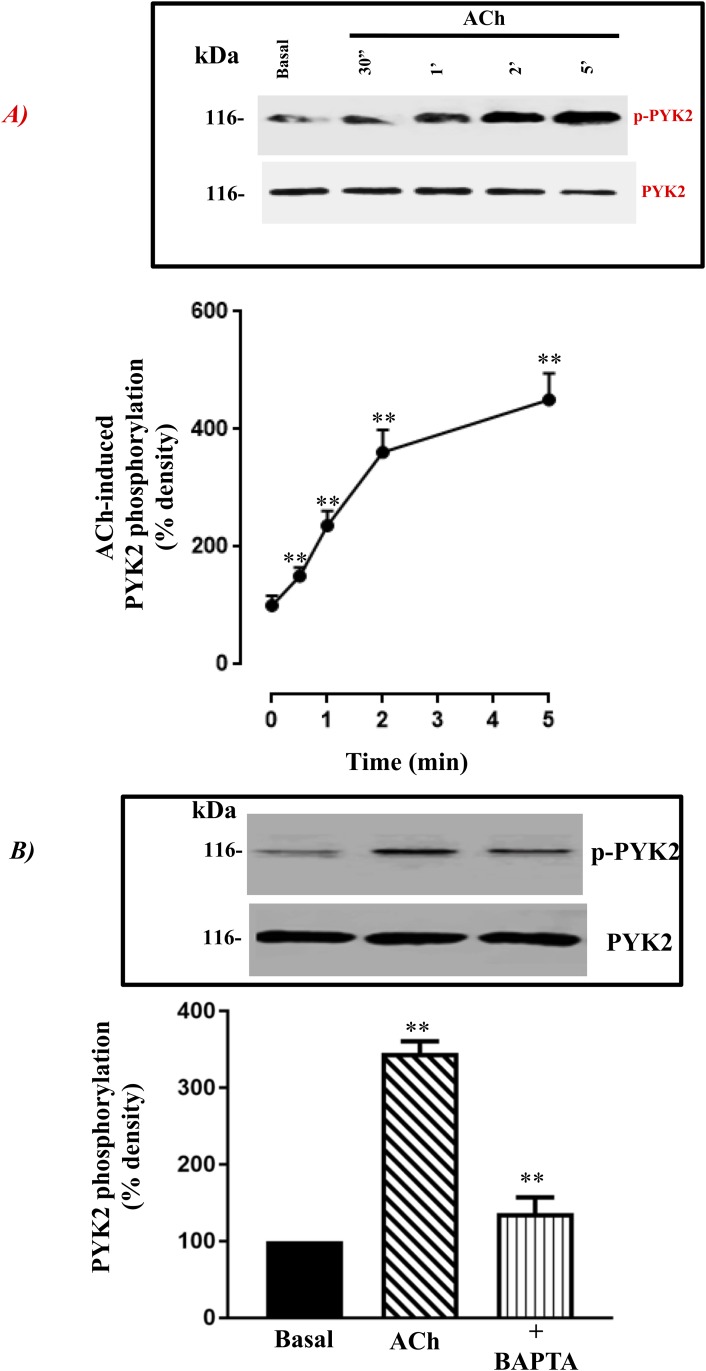
Increase in Pyk2 phosphorylation by ACh.A: Immunoblots of Pyk2 and phospho-Pyk2 from extracts of smooth muscle cells either unstimulated or stimulated with 1 μM ACh for different time periods ≤ 5 min. Values are means ± SE of six experiments. B: Immunoblots of Pyk2 and phospho Pyk2 from extracts of smooth muscle cells either unstimulated or stimulated with 1 μM ACh in the presence or absence of Ca2+ chelator BAPTA (10 μM, 10 min). Phosphorylation of Pyk2 was measured using phospho-specific Tyr Pyk2 (Y402) antibody. The results are expressed as densitometric values. Values are means ± SE of three experiments. **P<0.001.